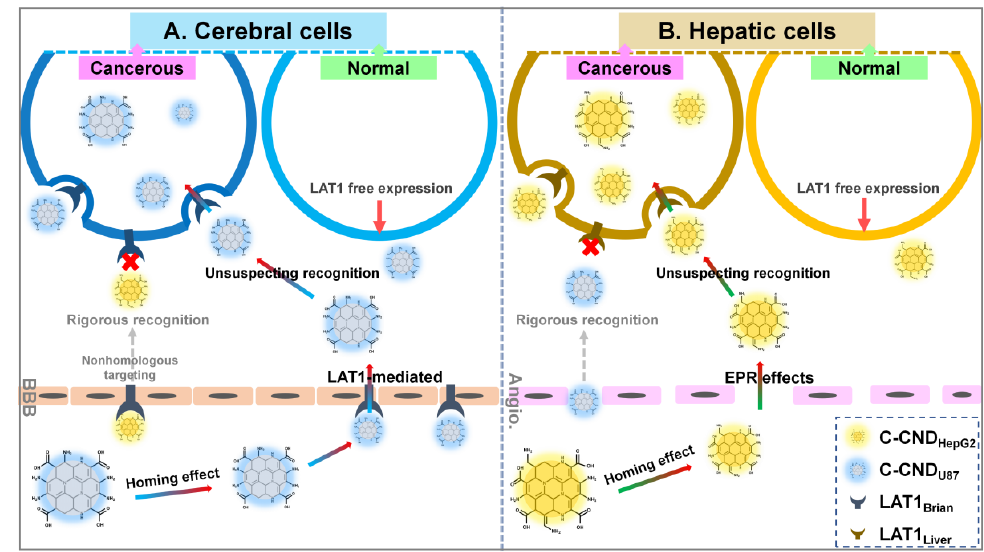
Scheme 1. Schematic diagram of in vivo imaging of the tumor cell-derived C-CND. ( A ) C-CND U87 mediated fluorescence targeted imaging for glioma across the BBB; ( B ) C-CND HepG2 mediated fluo- rescence targeted imaging for hepatic carcinoma. BBB: Blood – brain barrier, Angio.: Tumor angio- genesis.